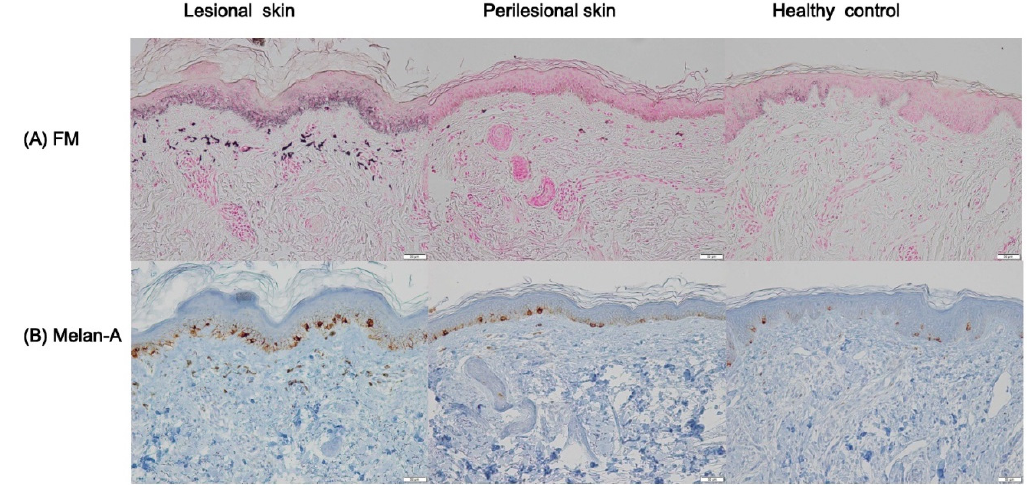
Figure 2. Immunohistochemical staining with Fontana–Masson stain and Melan-A in the lesional and perilesional normal-appearing skin of Riehl’s melanosis, and healthy control. ( A ) Fontana–Masson staining showed increased basal pigmentation in the lesional skin of Riehl’s melanosis (original magnification, 200 × ). Scale bar, 50 µ m. ( B ) Immunostaining for Melan-A showed an increase in the number of positive melanocytes in the lesional skin of Riehl’s melanosis compared to perilesional skin and healthy control (original magnification, 200 × ). Scale bar, 50 µ m. Abbreviation: FM, Fontana–Masson. Table 2. Quantitative analysis of epidermal pigmentation and the number of melanocytes in Riehl's melanosis and healthy controls.